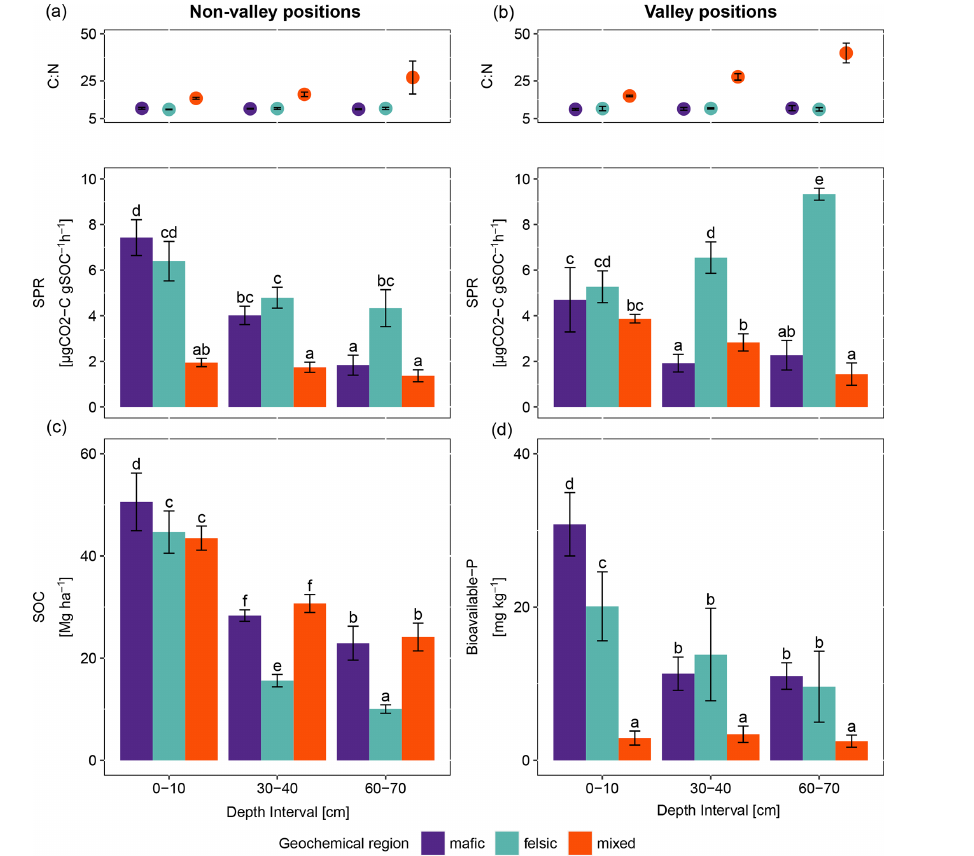
Figure 1. Average and standard errors based on field replicates. (a) C : N ratio as points (top) and specific potential respiration (SPR) as bars (bottom) for non-valley positions ( n = 9). (b) C : N ratio as points (top) and specific potential respiration (SPR) as bars (bottom) for valley positions ( n = 3). (c) SOC stocks and (d) bioavailable phosphorus for non-valley positions ( n = 9). The same letters on top of the bars indicate no significant difference following ANOVA tested for differences between depth intervals across geochemical regions. ANOVA tests were performed separately for non-valley and valley